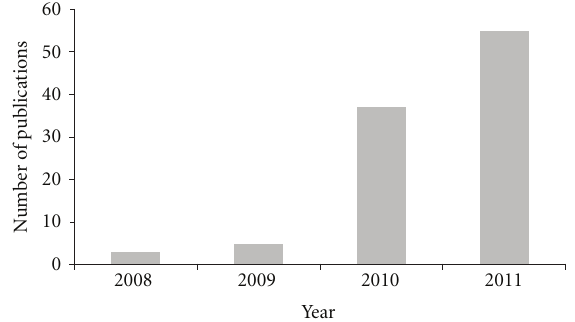
Figure 1: The number of publications regarding single-incision laparoscopic